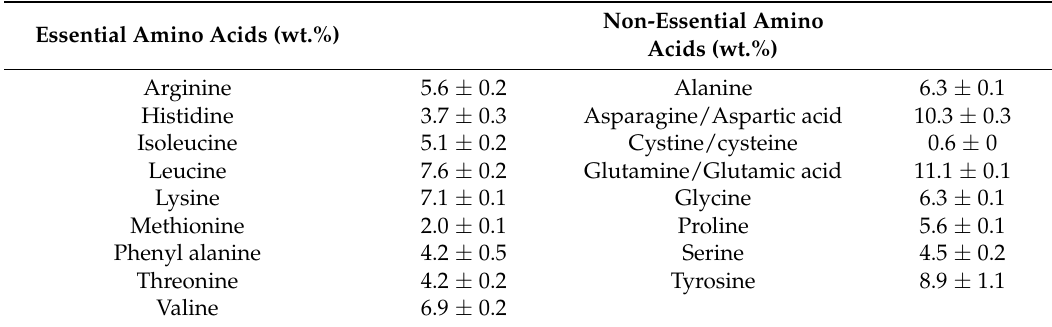
Table 1. Relative amino acid content a,b . Essential Amino Acids